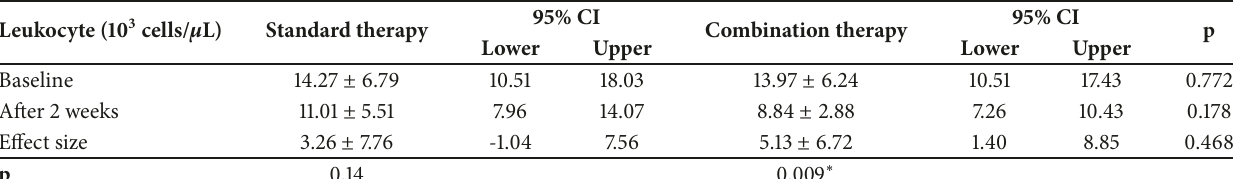
Table 3: Leukocyte count between groups.